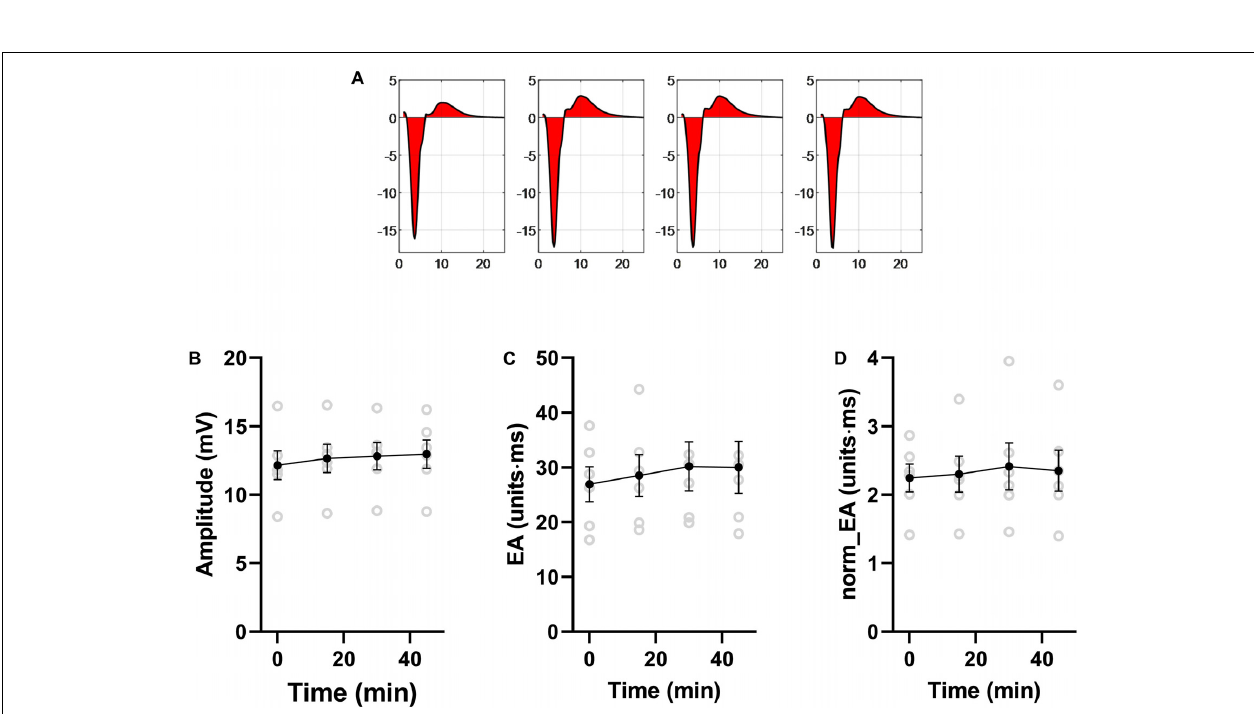
FIGURE 10 | Stability of bipolar electrogram metrics in isolated mouse hearts. Data showing the stability of measures of electrogram morphology in isolated mouse hearts. EA = electrogram area. norm_EA = amplitude-normalized electrogram area. n = 6 hearts.